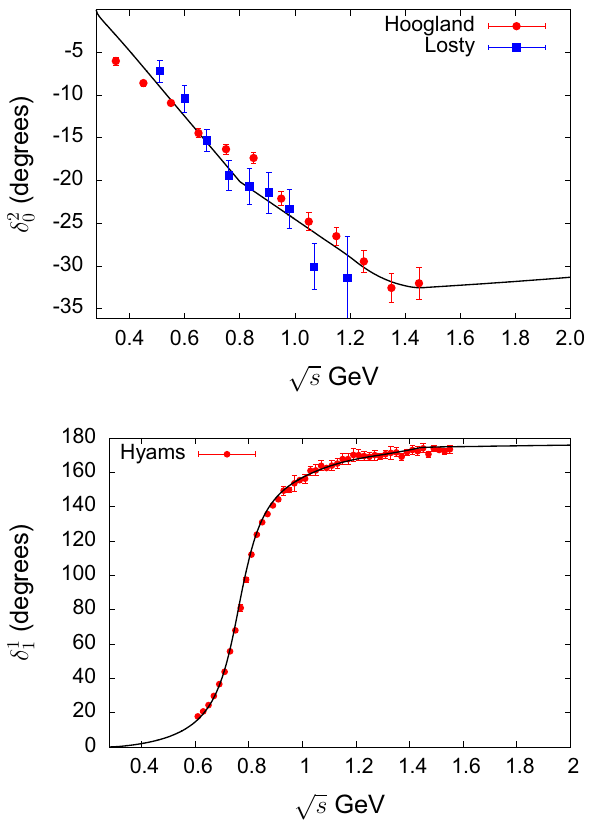
Fig. 5 Real part of the η → 3 π amplitude along the t = u line as a Fig. 4 The ππ phase shifts used for computing single-channel Omnès function of the energy s in two different regions. The yellow shaded functions for the I = 2 S -wave and the I = 1 P -wave area indicate the physical regions for the scattering ηπ 0 → π + π − ( upper figure ) and the decay η → π + π − π 0 ( lower figure ). The red solid curve corresponds to the solution of the coupled-channel Khuri– Finally, the phase shifts which we used for the I = 1 Treiman equations and the dashed curve to the single-channel solution. ππ P -wave and the I = 2 S -wave, for which inelasticity is The blue dash-dotted curve is the chiral O ( p 4 ) result √ s ≤ 0 . 8 ignored, are shown in Fig. 4. In the energy region GeV, these phase shifts are given by the Roy equations solu- (b) In the region 0 . 7 (cid:2) s (cid:2) 0 . 97 GeV 2 the tion parametrisation of Ref. [46]. They are fitted to exper- imental data from [41] ( P -wave) and [52,53] ( I = 2) in √ ( ∞ ) = π , s ≤ 1 . 5 GeV and interpolated to δ 1 the region 1 ( ∞ ) = 0 in the higher-energy region. δ 2 0